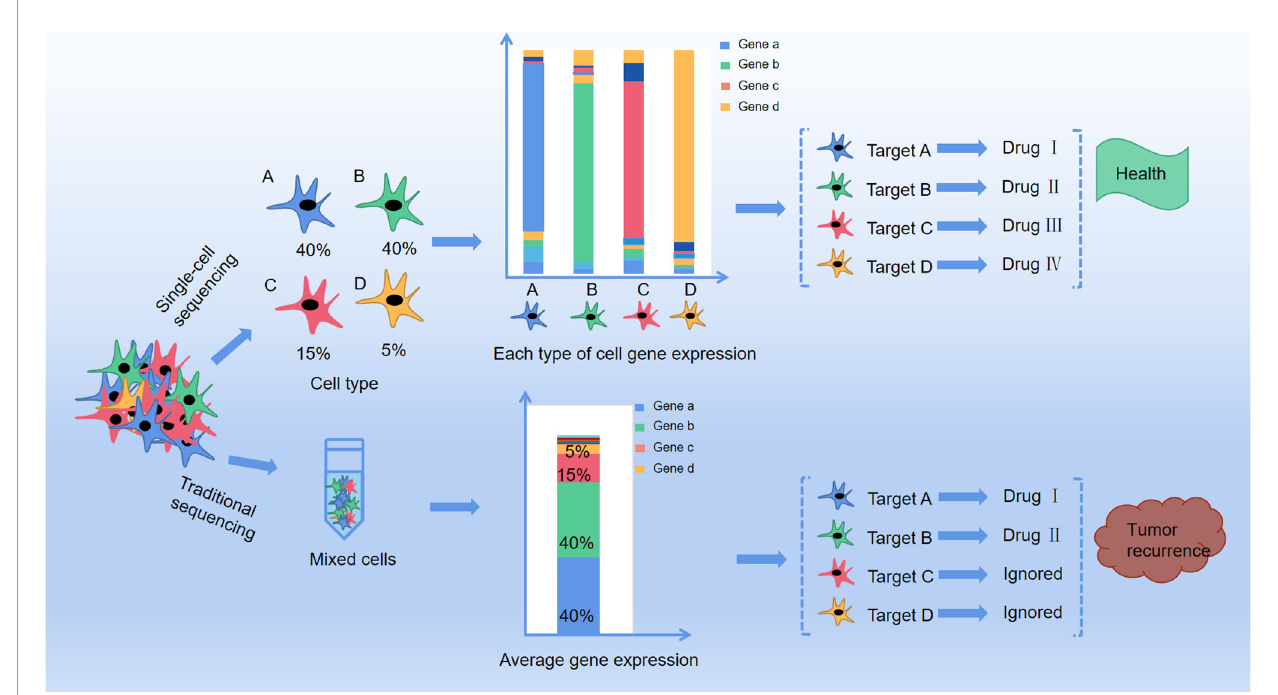
FIGURE 1 | The difference between traditional method and single cell method in pro fi ling anti-cancer targets. A 、 B 、 C and D represent four different cell types in cancer tissue with different distribution (A: 40%, B:40%, C:15%, D:5%), and each type of the cells present a target gene as gene a, b, c and d respectively by single cell sequencing. Drug I, II, III and IV are targeted drugs for gene a, b, c and d respectively, and with co-administration of drug I, II, III and IV the cancer is completely curable. However, with traditional RNA-sequencing, mixture of cell A, B, C, and D only presented target gene a and b With co-administration of drug I and II, only group of cell A and B are killed but cell C and D are still survival, leaving a chance for tumor